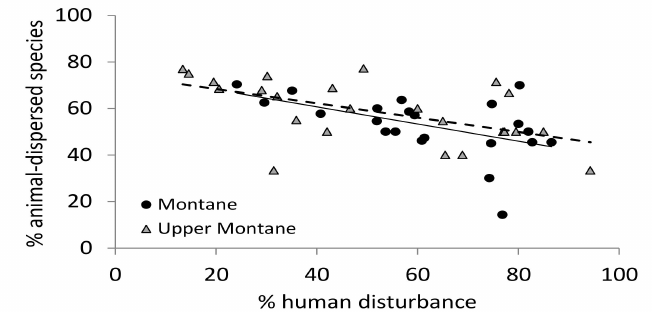
Figure 5. Linear regression of percent human disturbance on percentage of animal-dispersed species in each sacred church forest in the Montane zone ( n = 22; y = − 0.37x + 75.43, R 2 = 0.26; solid line, black circles) and Upper Montane zone ( n = 24; y = − 0.31x + 74.52, R 2 = 0.31; dashed line, grey diamonds) in the South Gondar Administrative Zone in northern